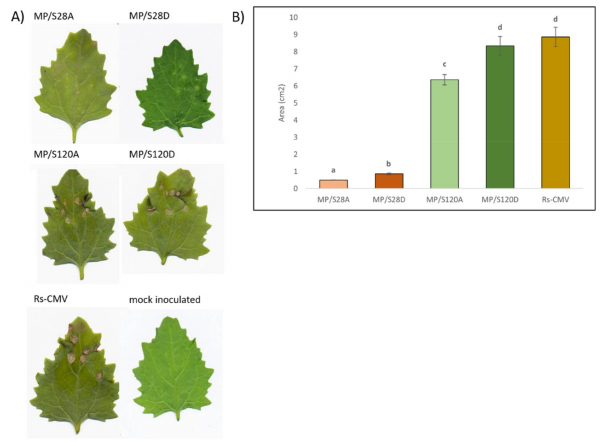
Figure 3. Local lesion development on Chenopodium murale 4 dpi with Rs-CMV and the MP mutants. ( A ) Local lesions on the inoculated leaves of Rs-CMV, MP/S28A, MP/S28D, MP/S120A and MP/S120D. ( B ) Diagram demonstrating the statistical analysis of lesion sizes (with standard devia- tion) induced by the different MP mutants and the wild type